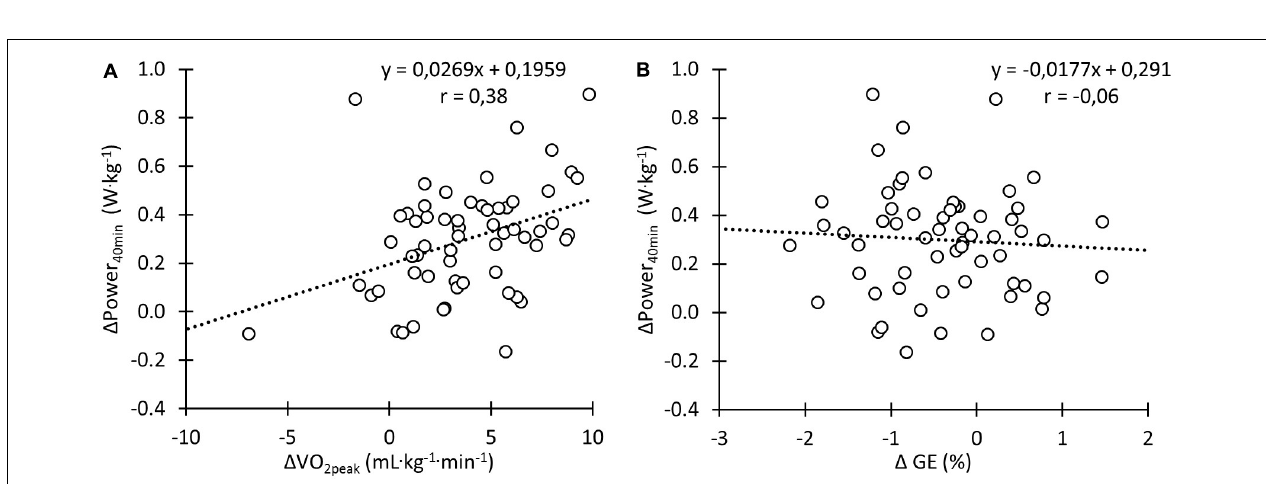
FIGURE 7 | Correlation between change in 40-min time trial performance normalized for body mass and change in ˙ V O 2peak normalized for body mass (A) and between changes in 40-min time trial performance normalized for body mass and changes in gross efficiency (B) during the training intervention.